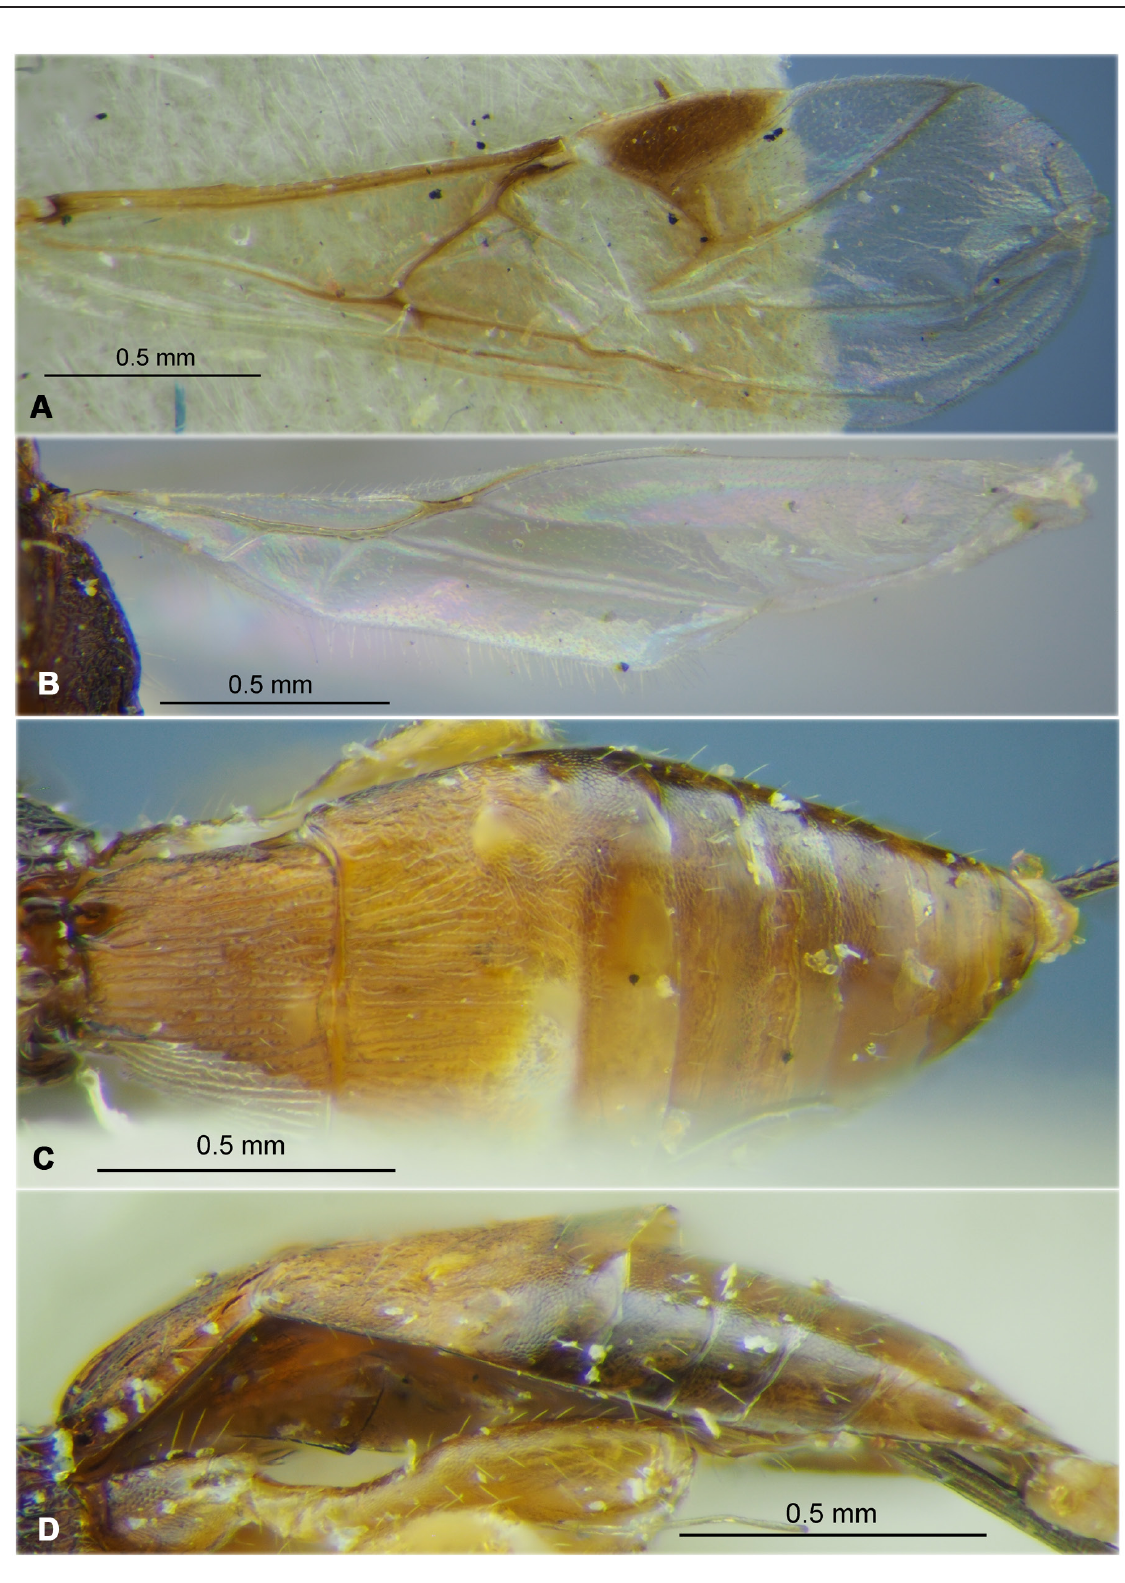
Fig. 31. Hecabalodes radialis Tobias, 1962, paratype, ♀ (ZISP). A . Fore wings. B . Hind wing. C . Metasoma, dorsal view. D . Metasoma, lateral